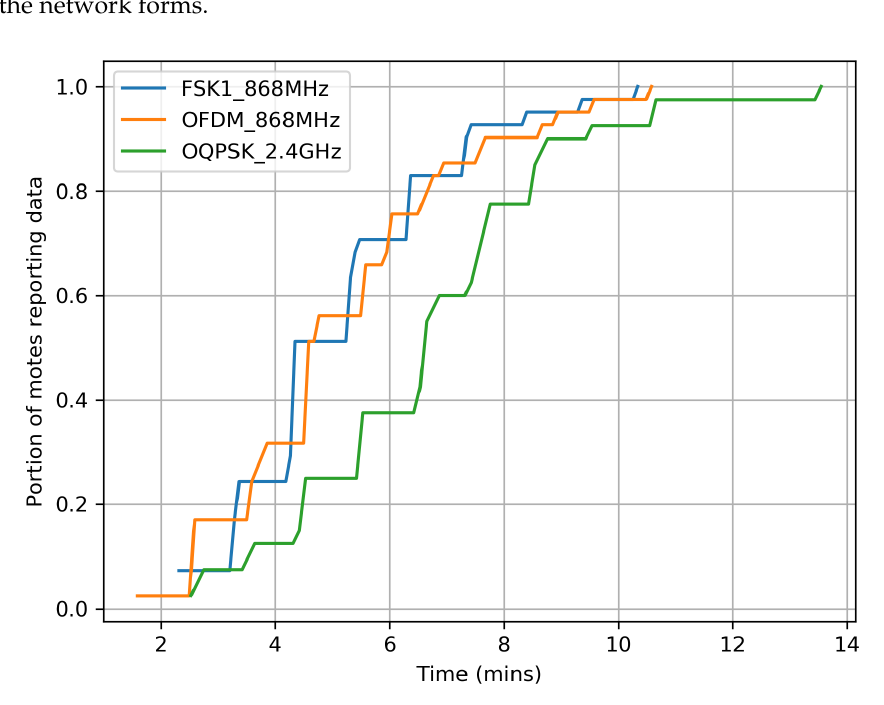
Figure 4. The network tends to form faster when using a longer-range